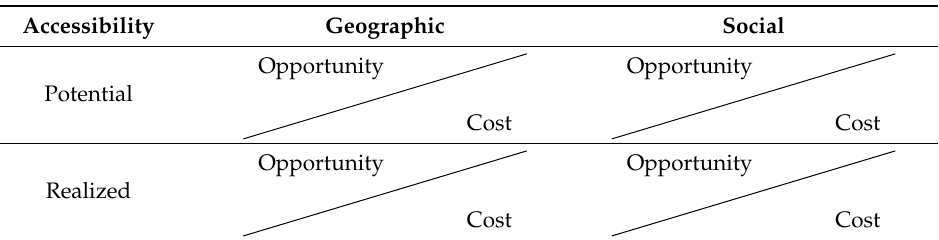
Table 1. The Khan model of